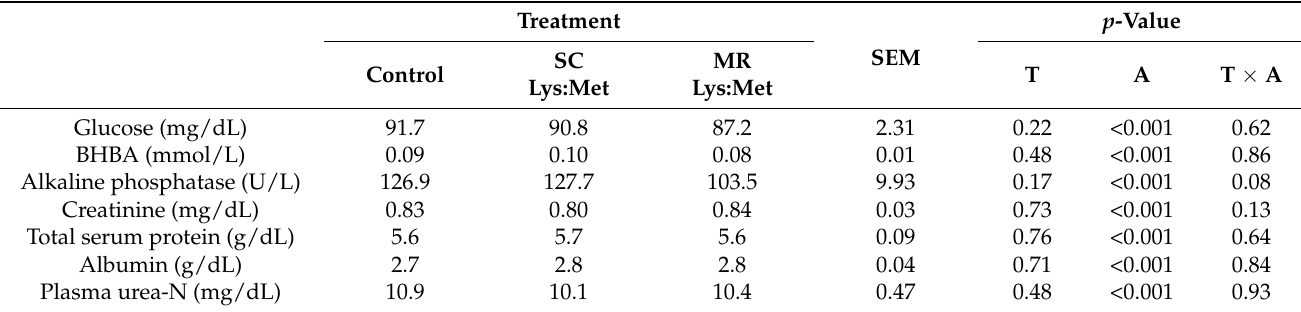
Table 3. Blood metabolites of dairy calves in the step-up/step-down feeding system with or without lysine and methionine supplementation in starter or milk